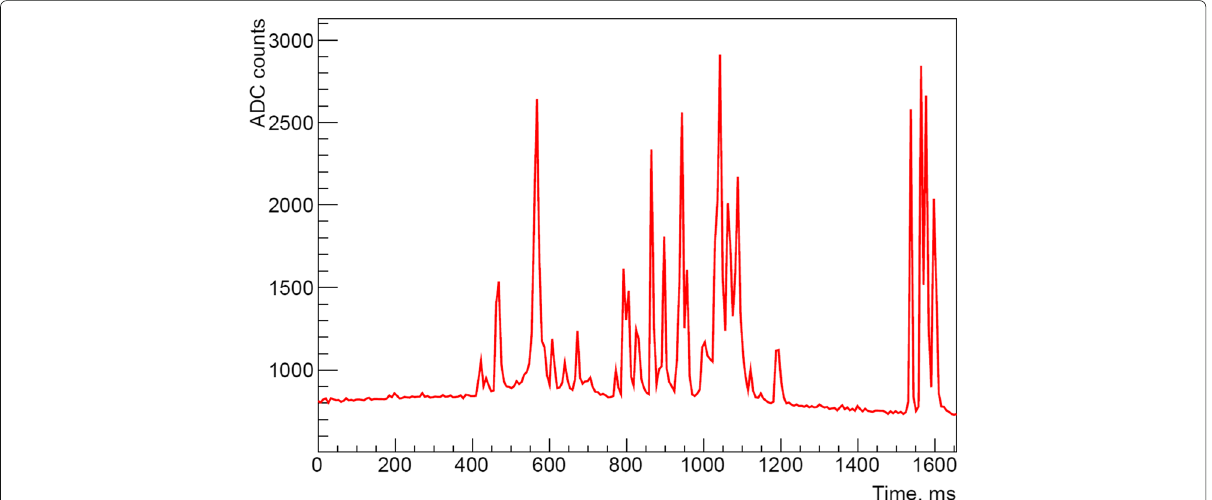
Fig. 4 Waveforms of a pixel brightness for an event detected at 03:23:27 UTC, January 4, 2017 above South America. Sampling time is equal to 6.6